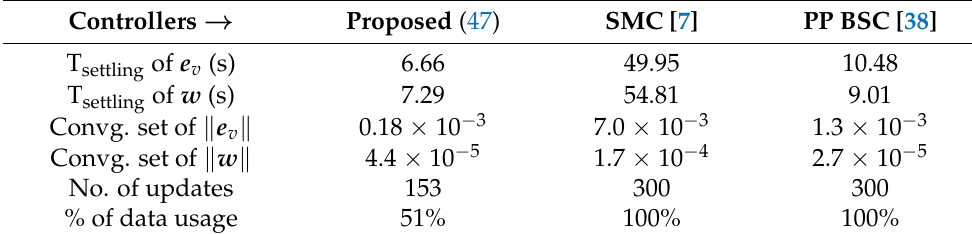
Table 2. Performance measures under different